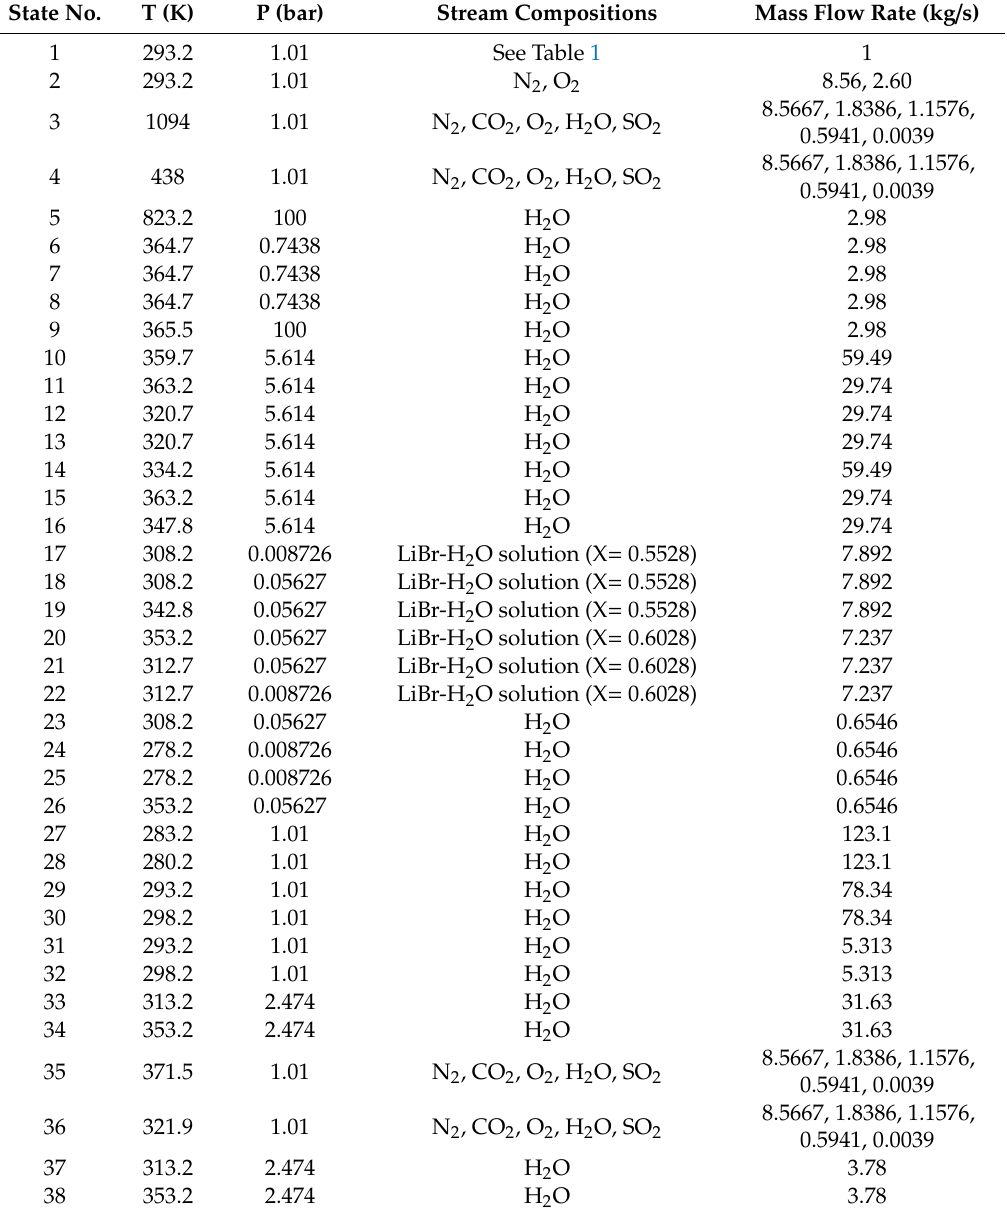
Table 3. Thermodynamic and economic properties in each state point of the proposed CCHP. State